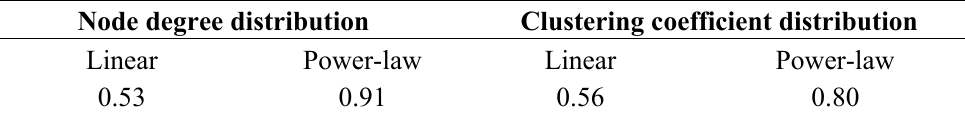
Table 3. Network model comparison. R 2 as metric of goodness of distribution